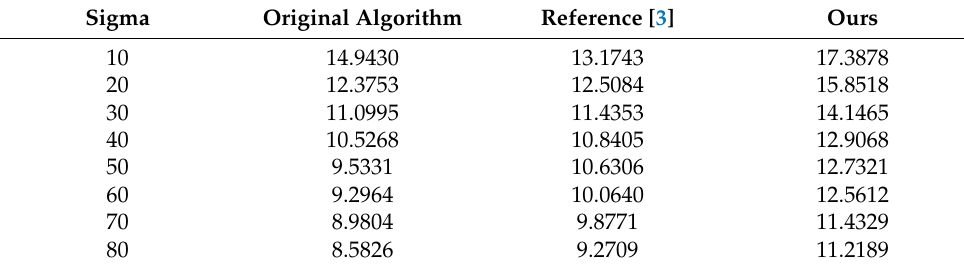
Table 8. PSNR of the three algorithms for the MIT image.